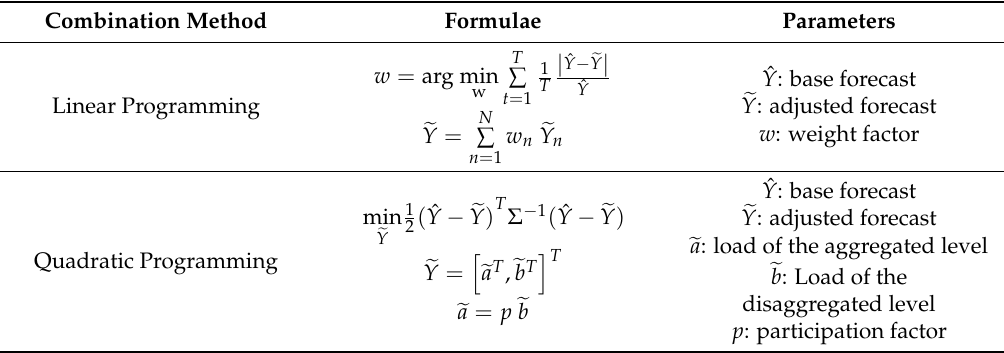
Table 4. Combination methods for base